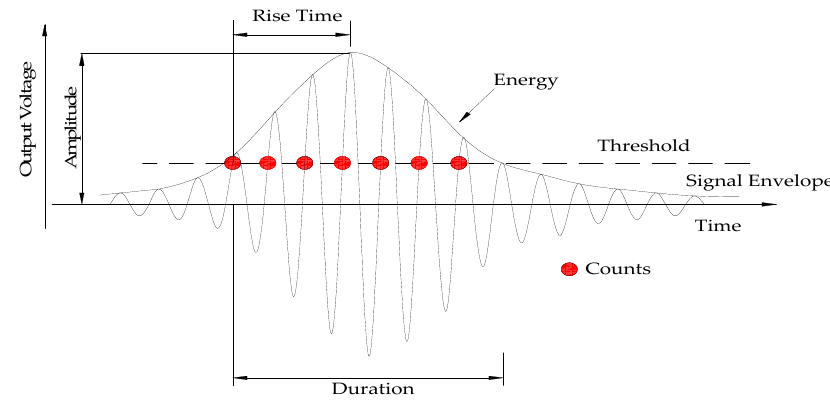
Figure 3. Basic parameters of AE.